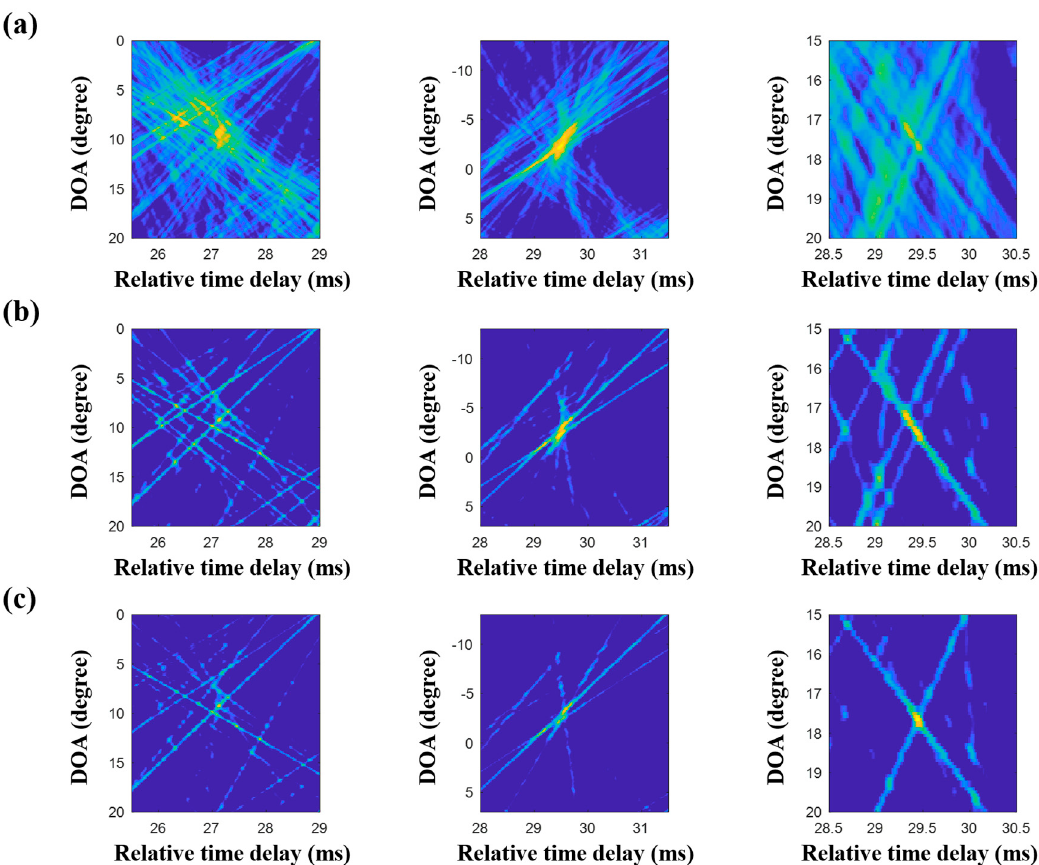
Figure 18. Enlarged parts of the results of delay-and-sum beamforming from three different schemes that were applied to estimate the CIRs at the array using multiple measurements: ( a ) matched filter (MF), ( b ) compressive sensing (CS) using the time delay for each single snapshot, and ( c ) CS using the time delays over multiple snapshots. The ambiguities decrease as the techniques become more sophisticated.